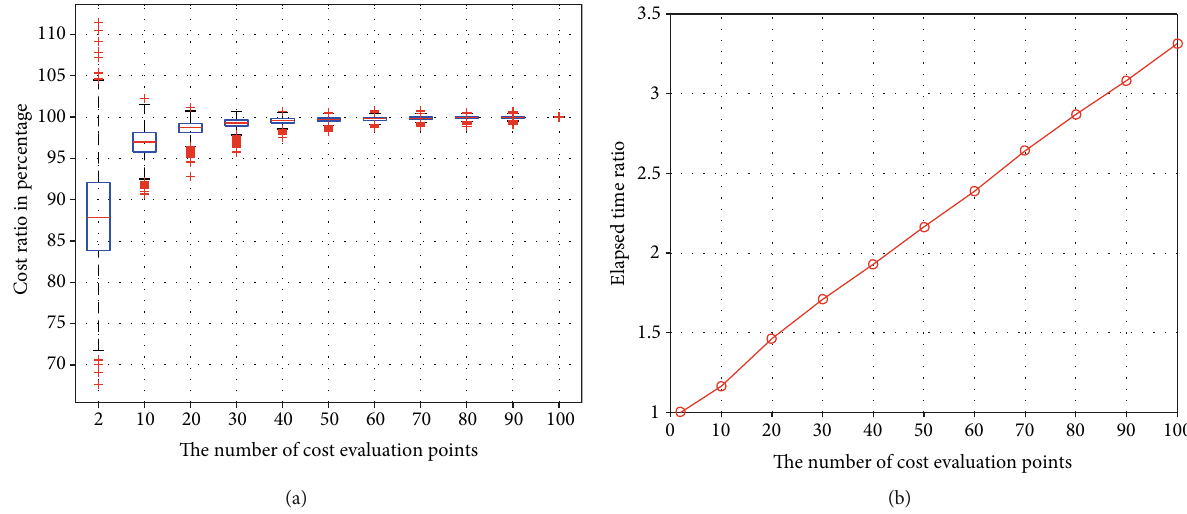
Figure 20: The cost ratio (a) and the elapsed time ratio (b) according to the number of cost evaluation points between two adjacent